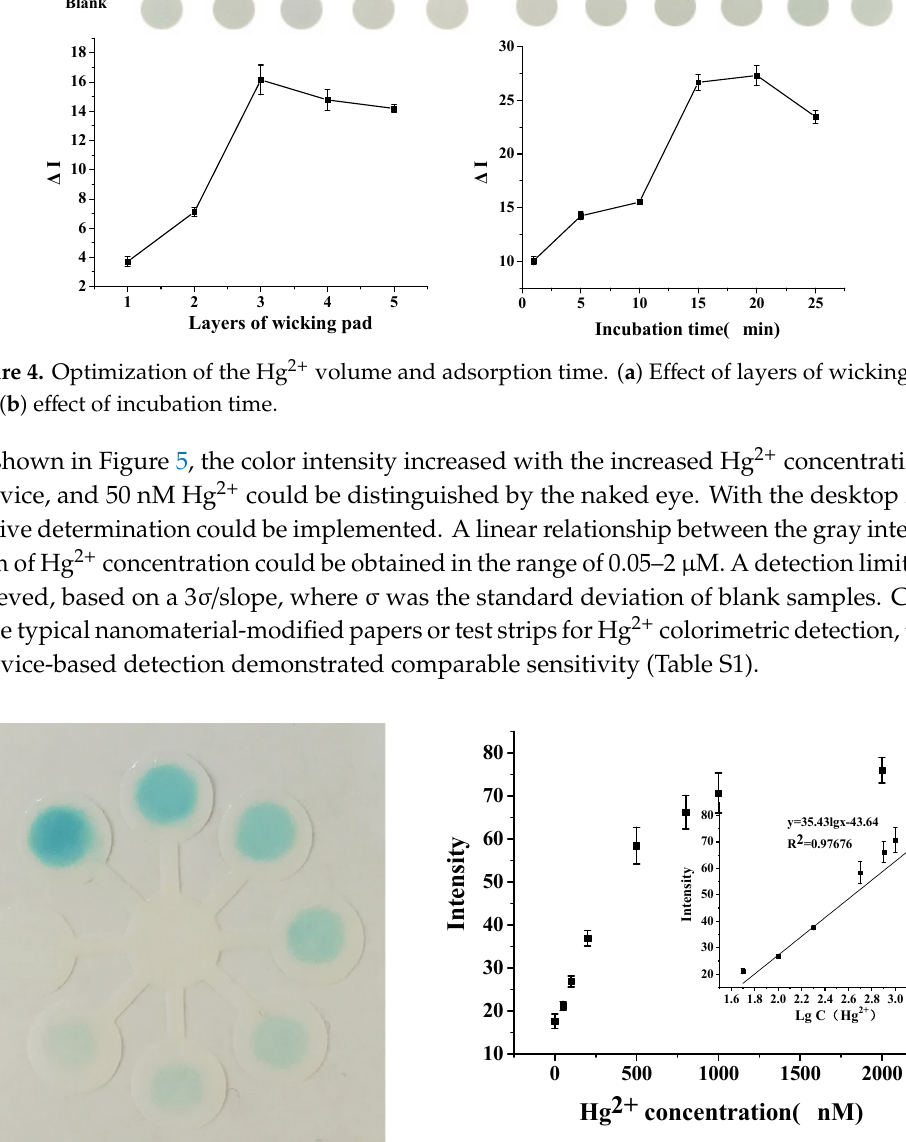
Figure 6. Selectivity of the method toward heavy metal ions. 3.3. Application in Real Samples To verify the feasibility of this paper device in detecting real samples, tap water and lake water samples were spiked with Hg 2+ and applied to the paper device. The results were obtained as shown in Table 1. The recoveries ranged from 85.7% to 105.6% when water samples spiked with 200, 500, and 1000 nM Hg 2+ were measured. These results showed the great potential of this paper device for Hg 2+ detection in practical applications. Table 1. Determination of Hg 2+ in tap water and lake water samples. (n = 3). Sample